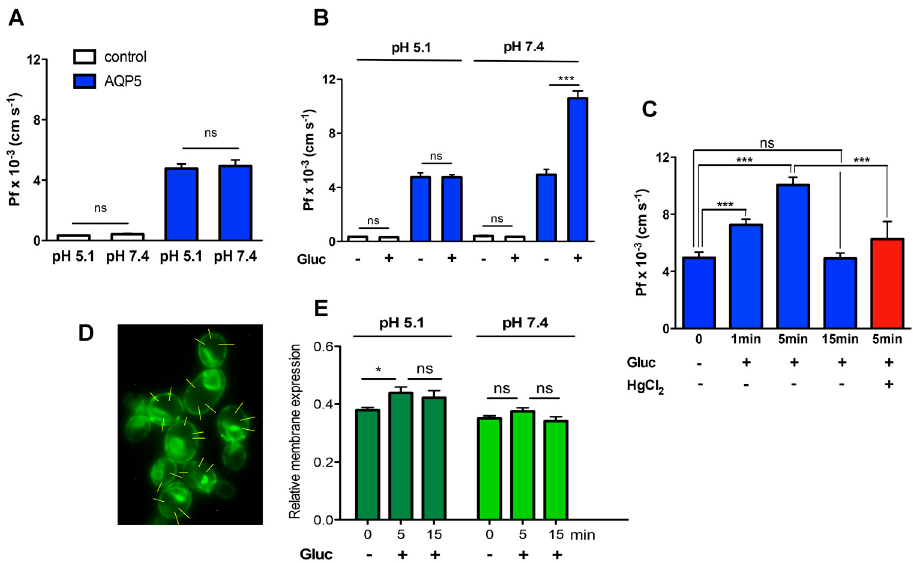
Figure 2. Regulation of AQP5 water permeability. ( A ) Water permeability Pf at pH 5.1 and pH 7.4 of control cells (Pf = (0.35 ± 0.01) × 10 − 3 and (0.41 ± 0.05) × 10 − 3 cm·s − 1 , respectively) and yeast cells expressing AQP5 (Pf = (4.77 ± 0.32) × 10 − 3 and (4.94 ± 0.40) × 10 − 3 cm·s − 1 , respectively); ( B ) Water permeability Pf at pH 5.1 and pH 7.4 upon an external glucose pulse ( C ) Time course of glucose-induced phosphorylation (1, 5 and 15 min, pH 7.4) and inhibition of AQP5 by HgCl 2 0.05 mM. Data are mean ± SD of 10 measurements; ( D ) Representative epifluorescence images of GFP-tagged AQP5 localization in yeast cells (100× objective); linear intensity profiles are indicated ( yellow lines ); and ( E ) Relative membrane expression of AQP5 calculated from fluorescence intensity profiles (30 cells in each experimental condition, 3 profiles for each cell, from at 3 independent experiments). ns, non significant, * p < 0.5, *** p < 0.001.